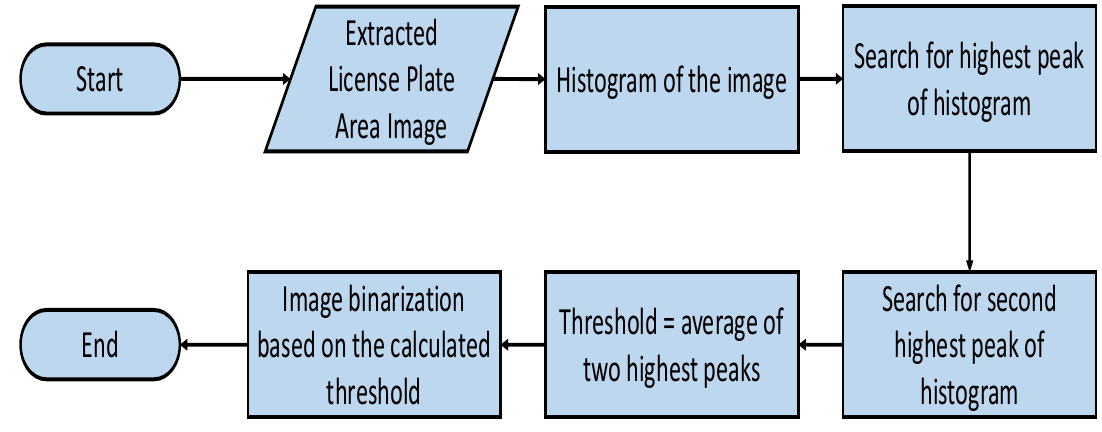
Figure 5. Thresholding algorithm to convert the LP grayscale image to